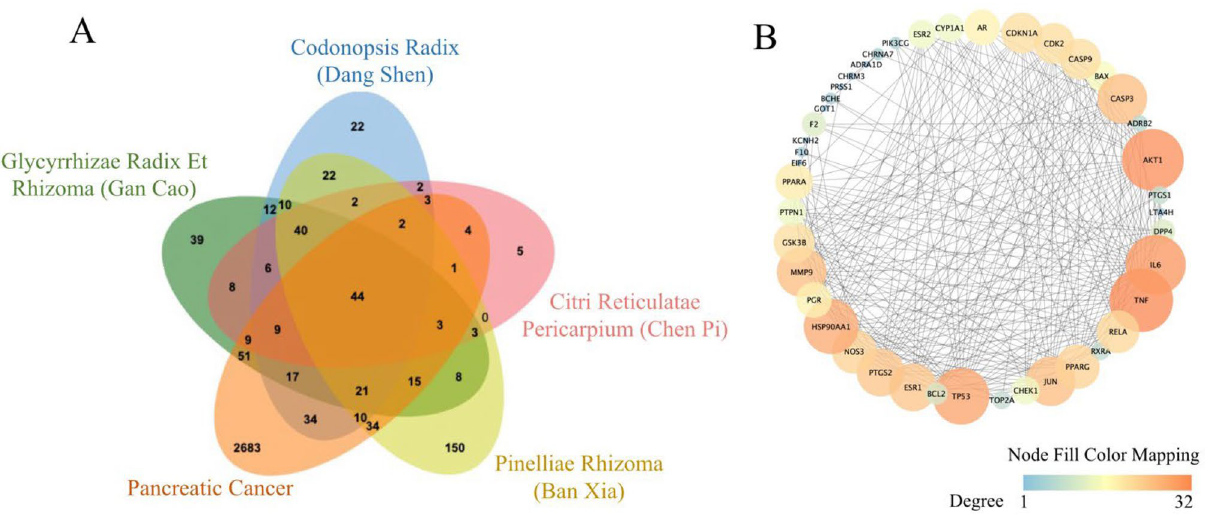
Figure 4. Targets of core prescriptions used for PDAC treatment. ( A ) Molecules in common between herb targets and PDAC-associated proteins. ( B ) PPI network diagram of the common targets of the four core herbs used to treat PDAC. The PPI network contains 44 nodes and 297 edges. Circles represent protein targets; orange circles indicate higher degree values. The node size of gene targets is proportional to the number of